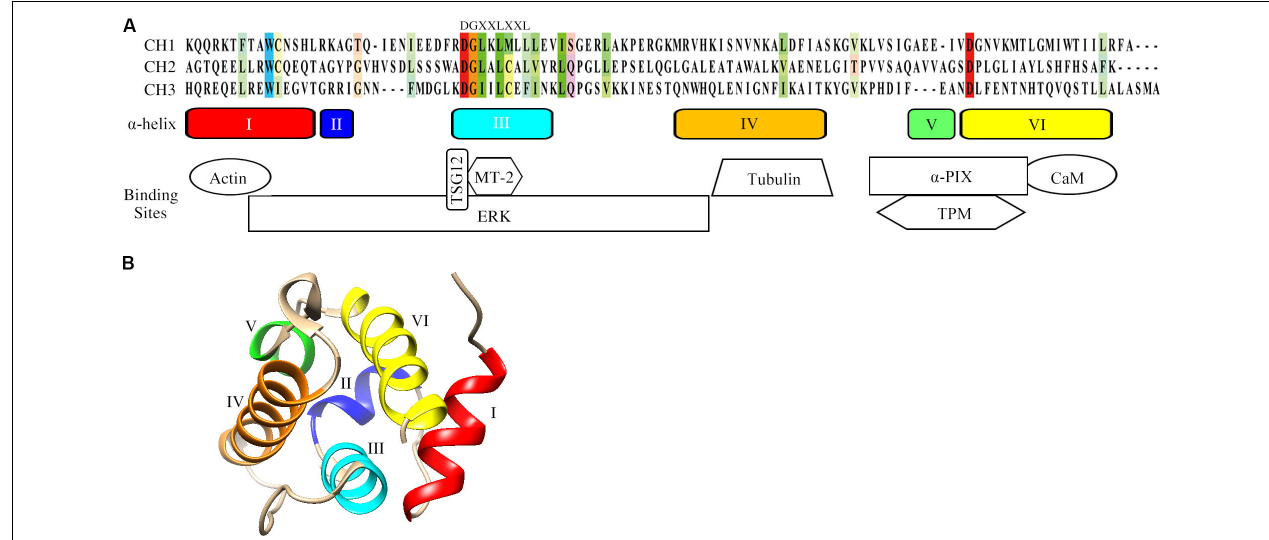
FIGURE 1 | Structural characteristics of the CH domain. (A) Sequence alignment, schematic of the secondary structure elements and the binding sites of CH domain for actin and signaling proteins. The conserved residues among the three CH domains are colored. Schematics of the secondary structure elements of CH domain and binding sites are also included. UniProt identifiers for CH1 ( α -actinin), CH2 (MICAL, Molecule interacting with CasL) and CH3 (calponin-1) are P12814, Q8TDZ2, P51911. (B) The tertiary fold of the calponin CH domain (PDB: 1H67). The CH domain contains in total six α -helices. Helices III and VI are approximately parallel, while helix IV is lying oblique aside. The structural model was generated by UCSF Chimera. Abbreviations: α PIX: Cdc42/Rac1-specific guanine nucleotide exchanging factor; CaM: calmodulin; ERK: extracellular signal-regulated kinase; MT-2: metallothionein-2; TPM: tropomyosin; TSG12: a specific transgelin-2